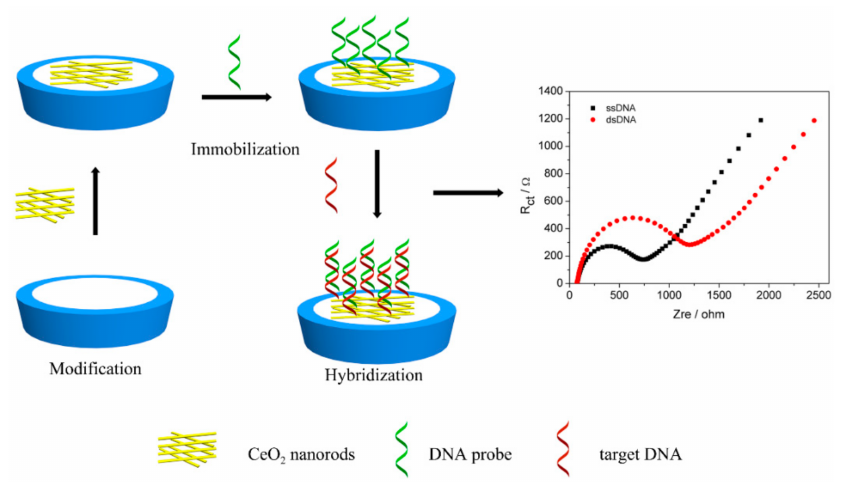
Scheme 1. Schematic of the preparation process of the DNA